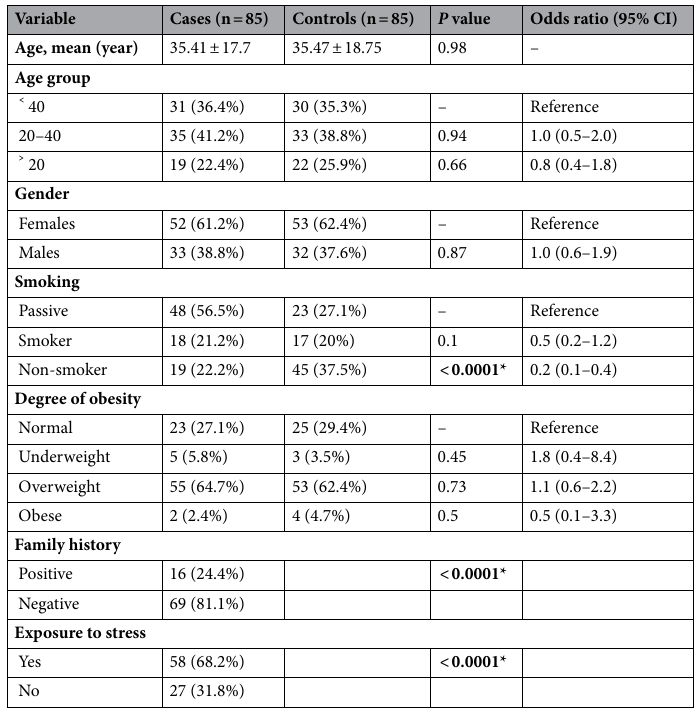
Table 2. Baseline characteristics and risk factors among the study population. Data are shown as number (percentage) or mean ± SD. * P value < 0.05 was considered as statistically significant. BMI body mass